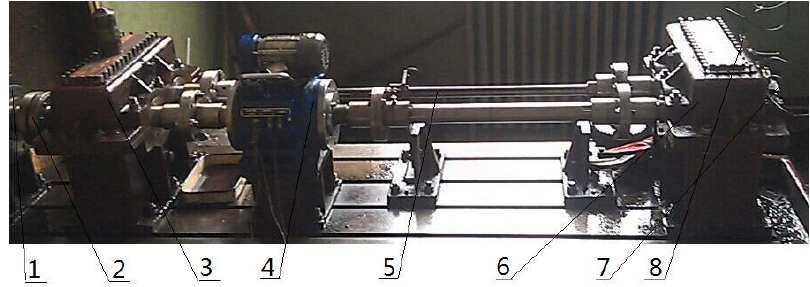
Figure 9. Gearbox test rig. 1—Speed regulating motor; 2—Clutch; 3—Companion gearbox; 4—Rotating speed torsion meter; 5—Torsion bar; 6—Test gear box; 7—Triaxial acceleration sensor 1#; 8—Triaxial acceleration sensor 2#.